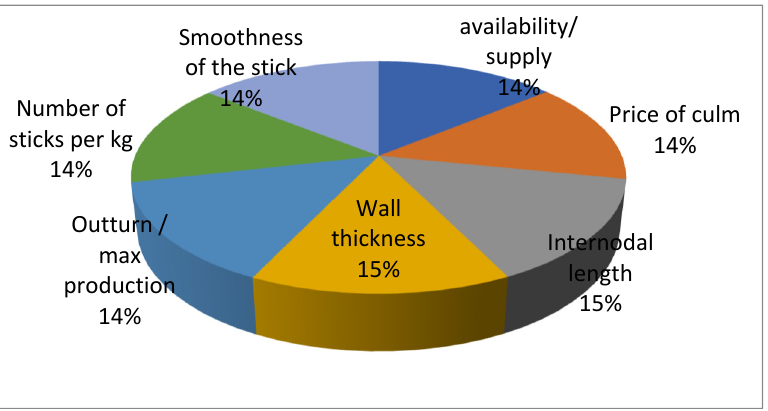
Figure 2. Percent contribution of different attributes for the choice of the age of culm for the incense stick industry.